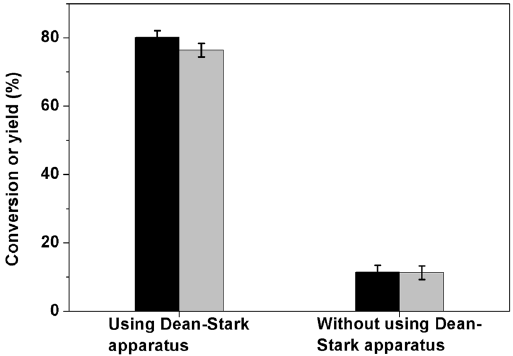
Figure 3. Conversion of compound 2 (black bars) and the carbon yield of compound 4 (gray bars) under the catalysis of NaOH. Reaction conditions: 443 K, 72 h; 20.0 g (0.143 mol) compound 2, 50 mmol NaOH and 20 mL p -xylene.